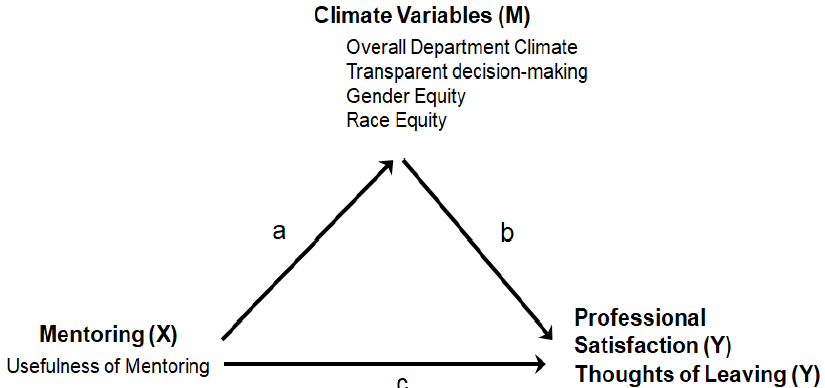
Figure 3. Conceptual mediational model examining whether the effect of faculty mentoring on professional satisfaction/turnover risk is mediated by differential perceptions of department climate.